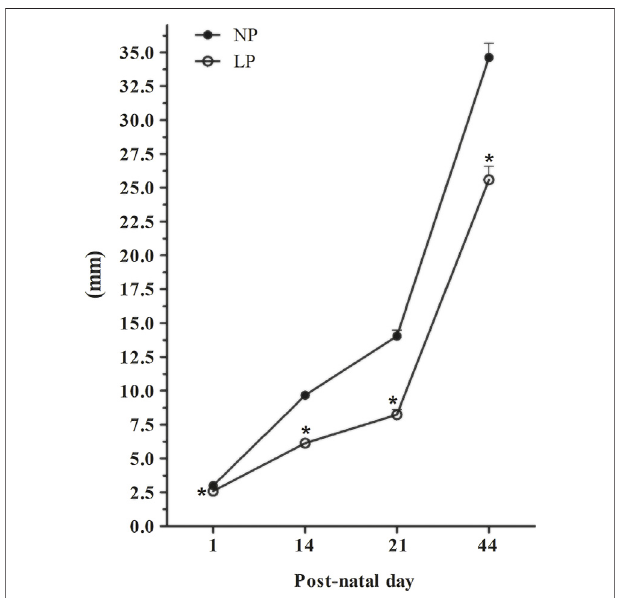
FIGURE2 | Evolution ofthe anogenital distance.PND 1:NP, n = 17, LP, n = 19; PND 14: NP, n = 19, LP, n = 26; PND 21: NP, n = 17, LP, n = 22; PND 44: NP, n = 12, LP, n = 10. Evolution of AGD in animals whose mothers received normal-protein and low-protein diets during gestation and lactation. The values are expressed as the mean ± S.E.M. * p < 0.05. Student t-test was used to assess the signi fi cance of parametric data, and Mann- Whitney test was used to assess the signi fi cance in nonparametric data.